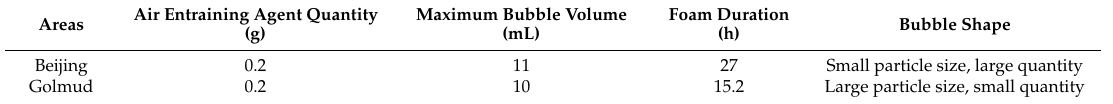
Table 1. Foaming results in Beijing and Golmud of